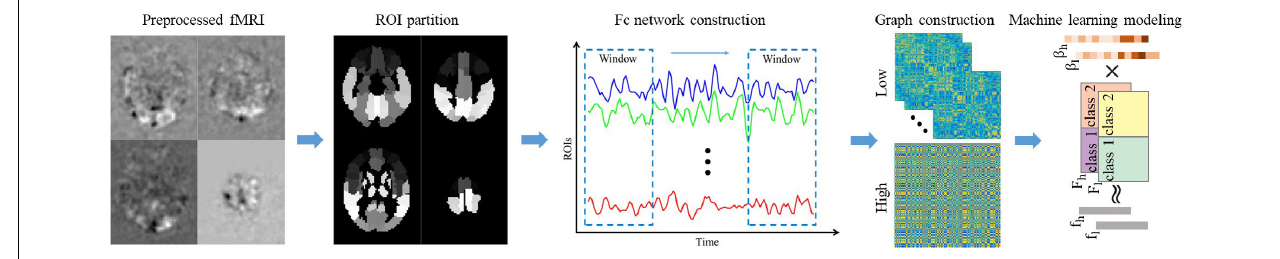
FIGURE 1 | The overall framework of the proposed method. The pre-processed fMRI is registered to the ALL brain template and divided into 90 ROI regions in advance. Then calculate the average gray value of each ROI regions to get the time series of each ROI region. Convert the time series of all ROI regions into low-order FC network diagrams through sliding window operation and correlation calculations. Perform clustering and correlation analysis of the low-order FC network to obtain the high-order FC network. Finally, extract the low/high-order FC network graph features, and establish machine learning model to recognize DNR.